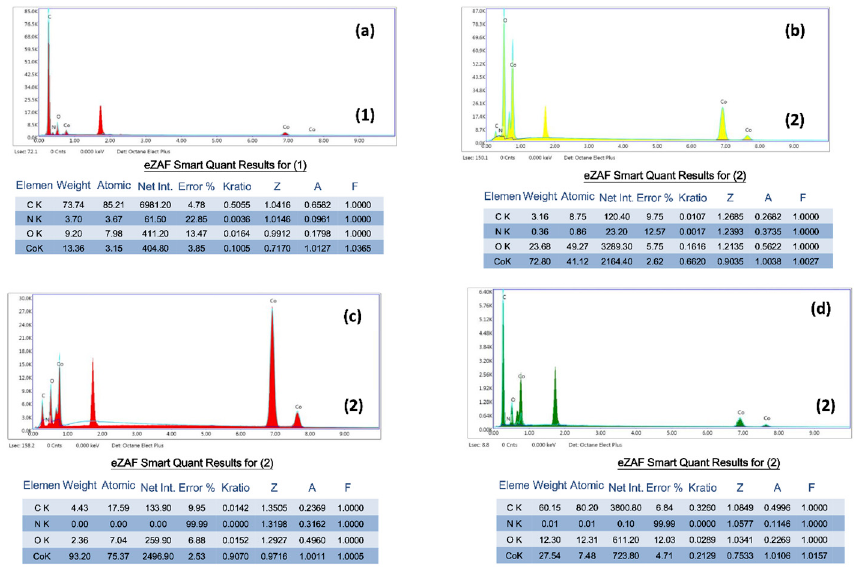
Figure 4. Energy dispersive X-ray analysis (SEM/EDX) ( a ) of (1); while ( b – d ) are for (2) in three different mapping regions.